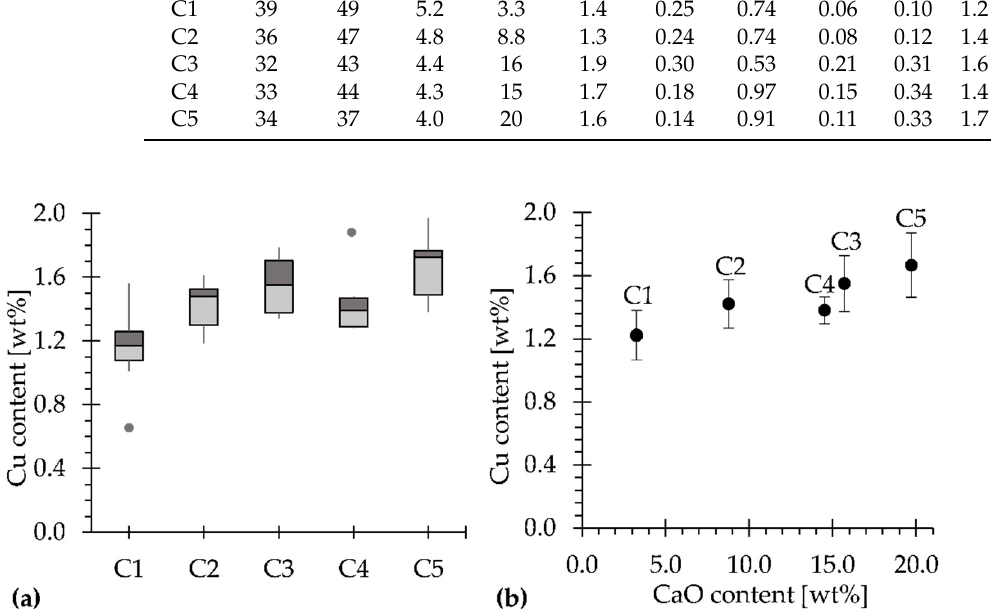
Figure 3. ( a ) Box plot of the ingoing copper content in batch C1–C5; ( b ) The average ingoing copper content in batch C1–C5 with corresponding standard deviation plotted against the CaO content.